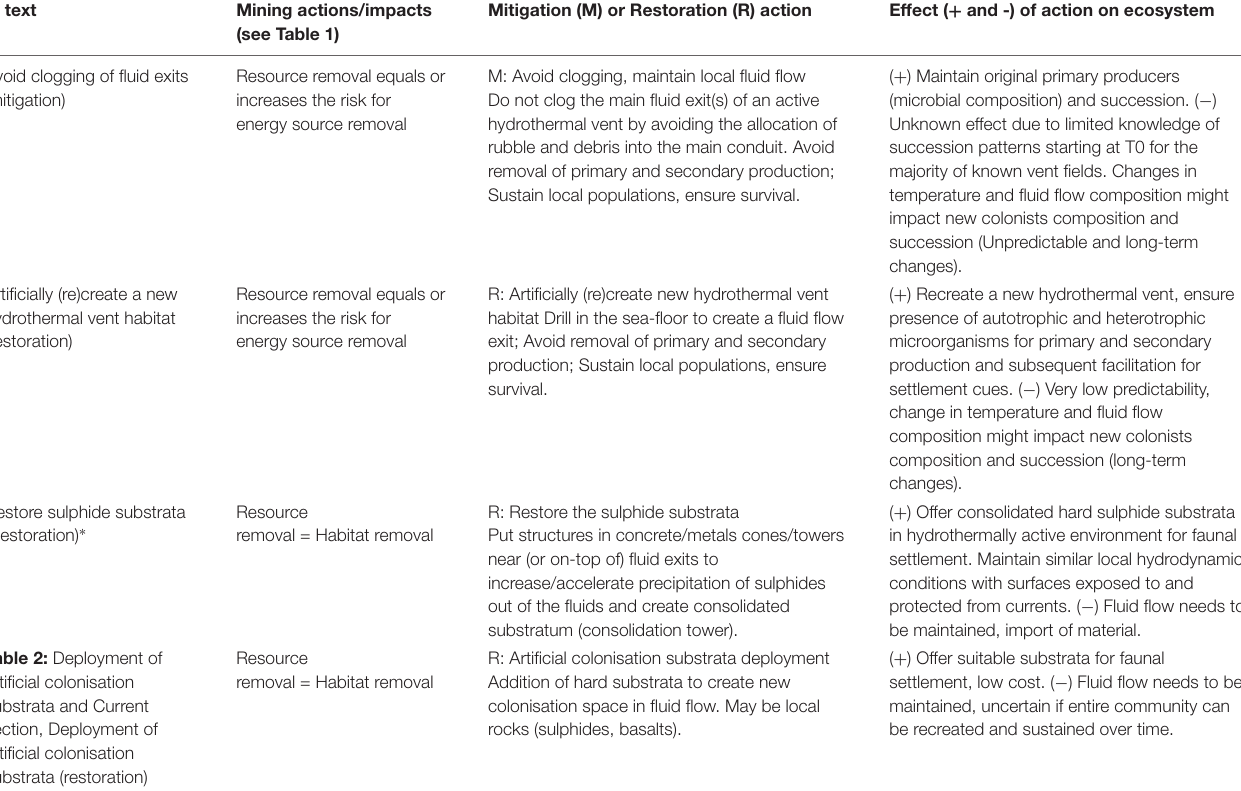
TABLE 3 | Proposed mitigation and restoration actions specifically for seafloor massive sulphide mining at hydrothermal vents.